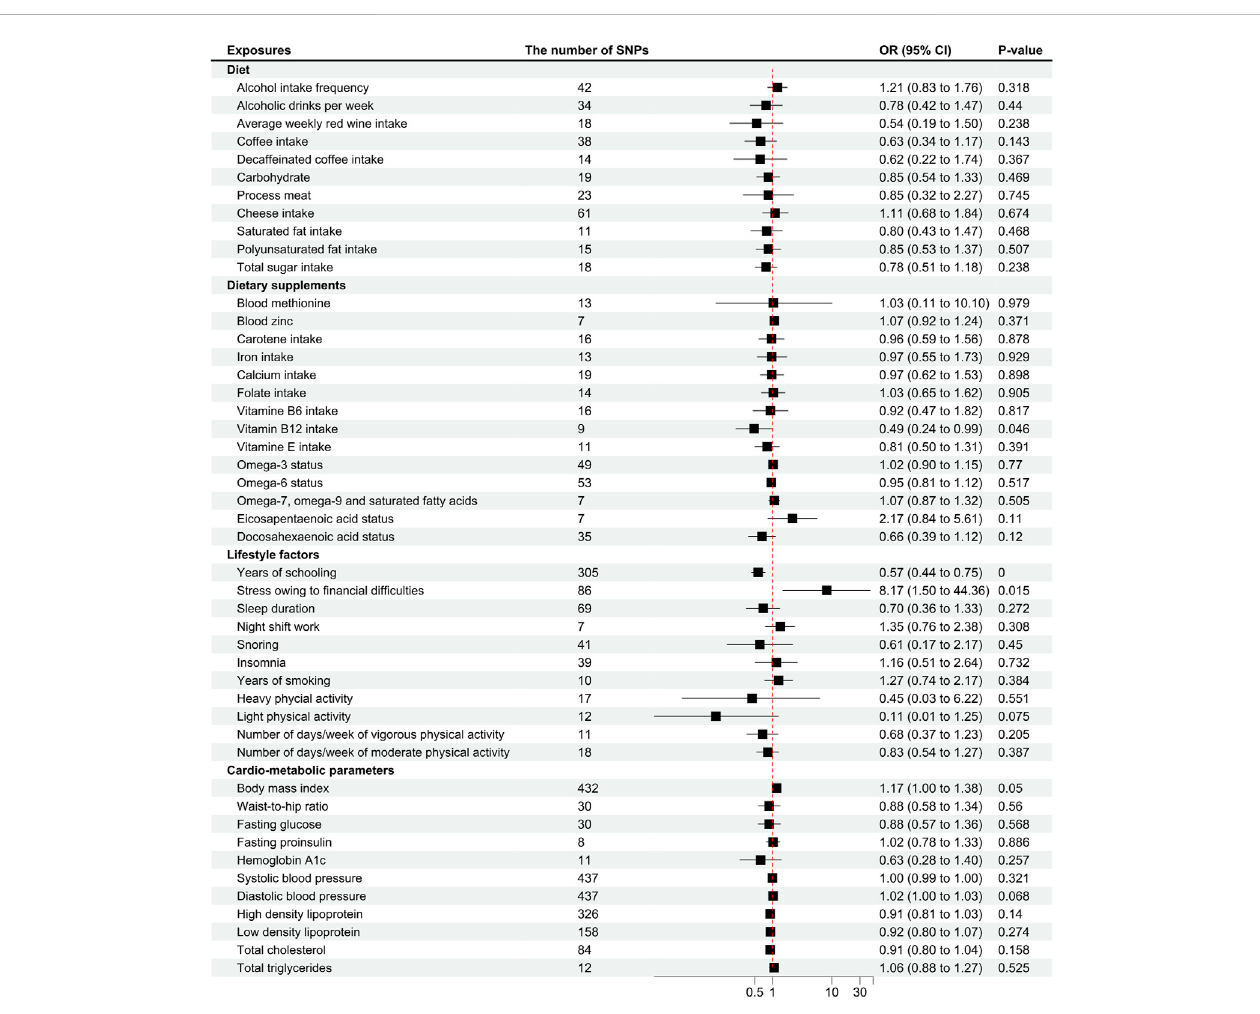
FIGURE 1 Oddsratiosforassociationsbetweengeneticallypredictedriskfactorsandmigrainewithoutaura.OR,oddsratio;SNP,singlenucleotidepolymorphisms. Annotation: We used the inverse-variance weighted method to calculate the odds ratios for individual SNPs. The odds ratio represents the odds ratio per genetically predicted SD unit increase in the risk factor. Take alcohol intake frequency for example, one SD unit increase in alcohol intake frequency was associatedwith1.21higheroddsofmigrainepathogenesis,whichindicatesthatahigherfrequencyofalcoholintakewasassociatedwithahigheroddsof migraine